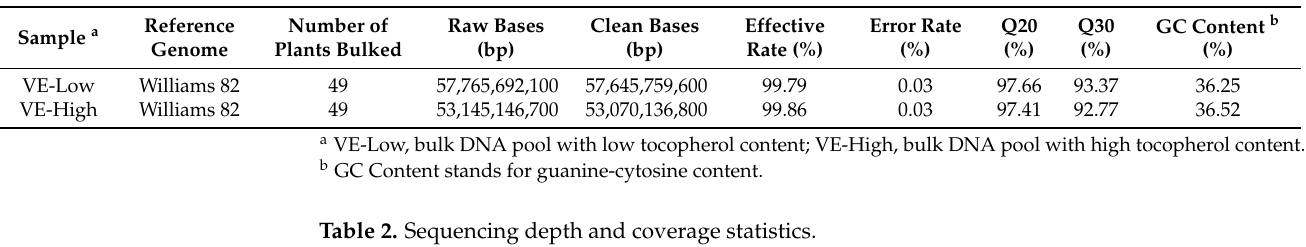
Table 1. Summary of sequencing data quality.